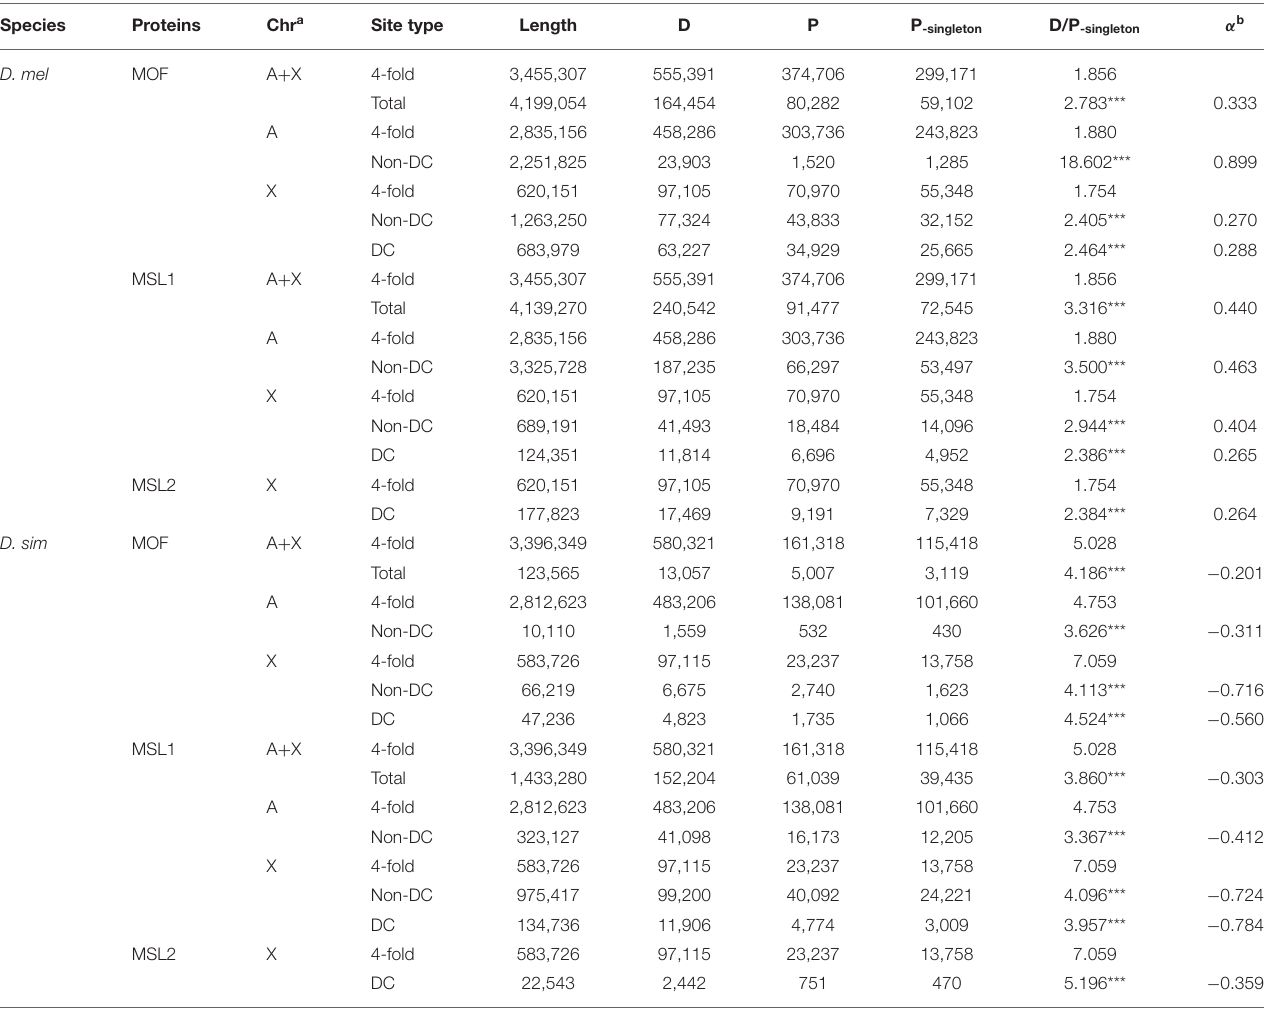
TABLE 1 | The McDonald Kreitman (MK) test of MOF and MSL1 DC and non-DC sites in D. melanogaster ( D. mel ) and D. simulans ( D. sim ).